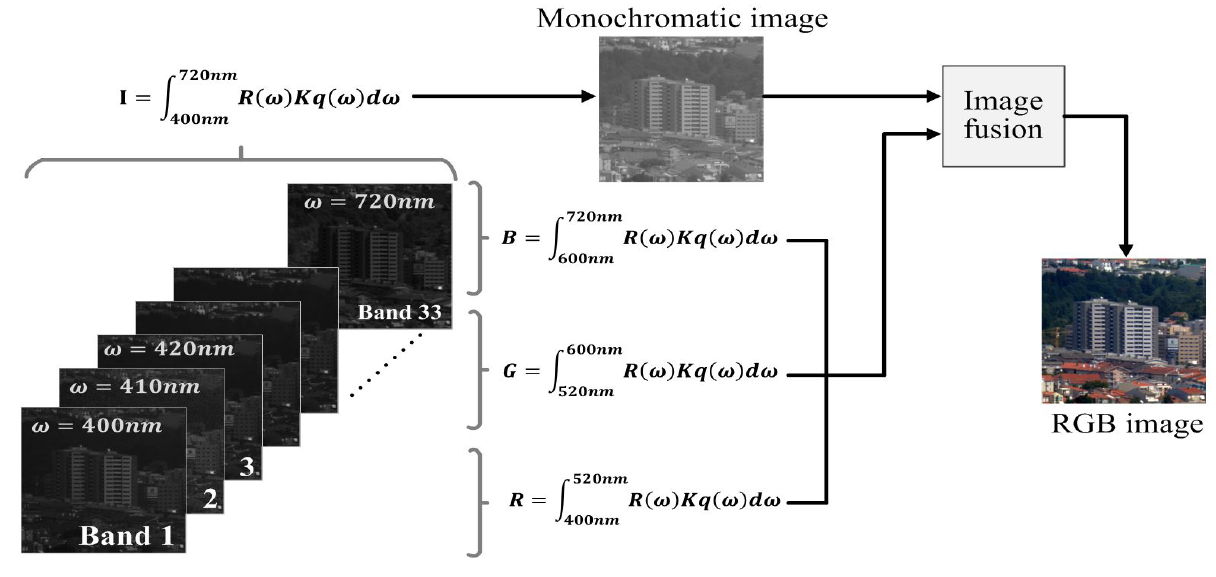
Figure 1. The multispectral imaging